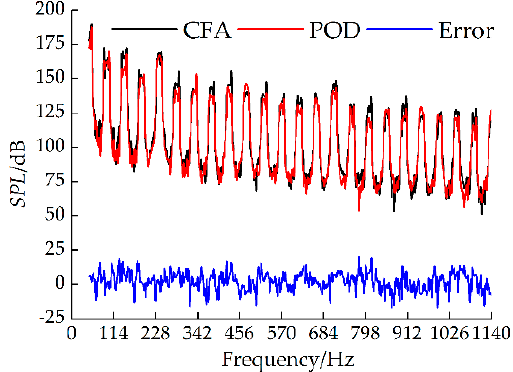
Figure 16. The POD reconstruction, computational fluid acoustics (CFA) calculation, as well as their error curves of impeller-induced hydrodynamic noise at outlet monitoring point.